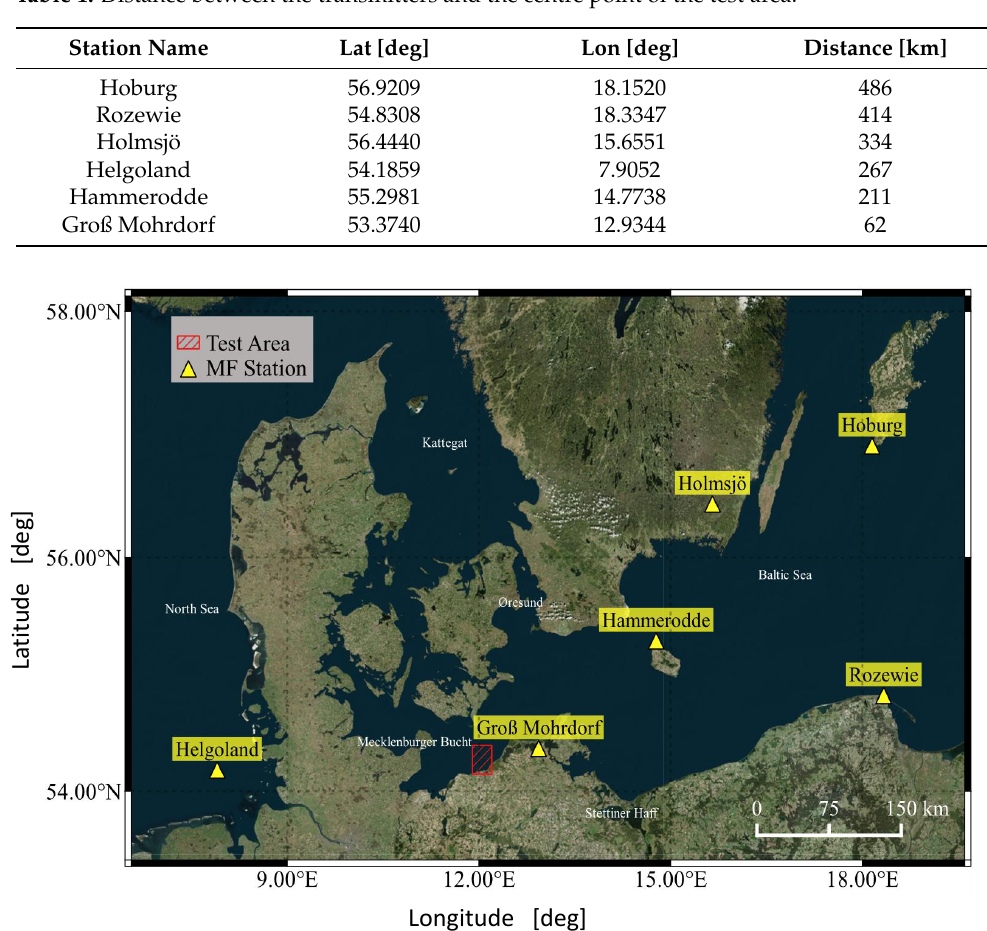
Figure 6. MF transmitters (yellow triangles) available during the campaign and test area (red